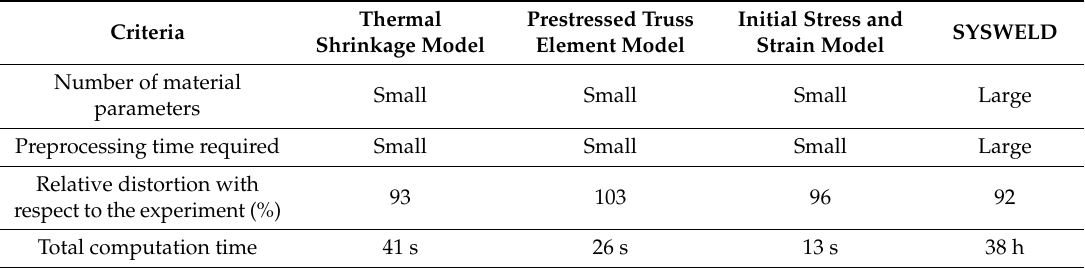
Table 4. SYSWELD vs. other models results [37].